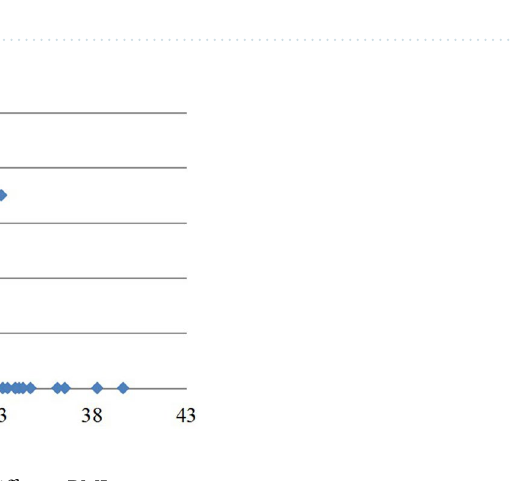
Figure 1. Shoulder pain scores in patients with different